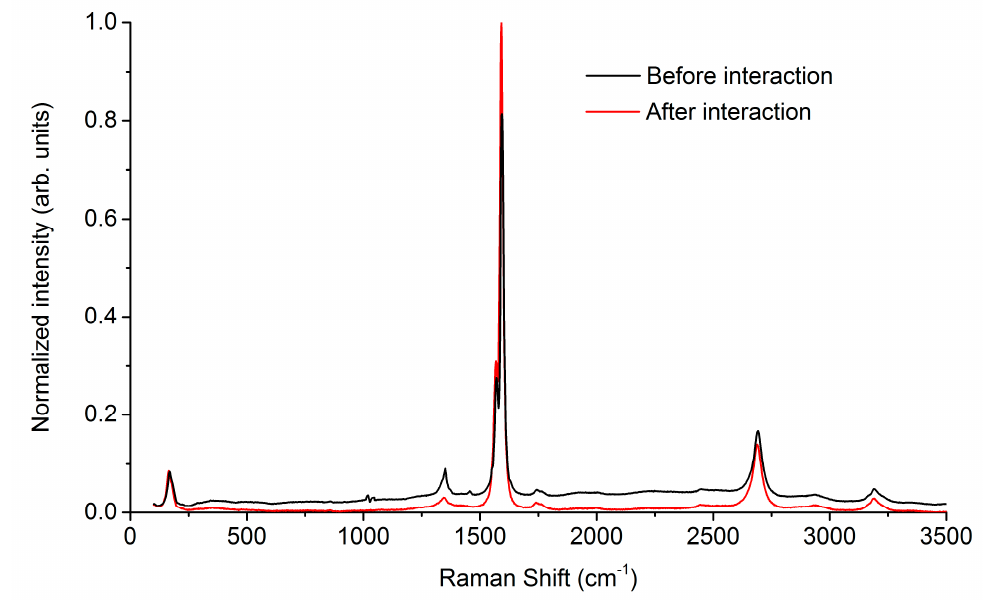
Figure 4. Raman spectra of the initial coating of SWCNT / collagen (black line) and (red line) after the implant was in the blood plasma during thermal cycling.